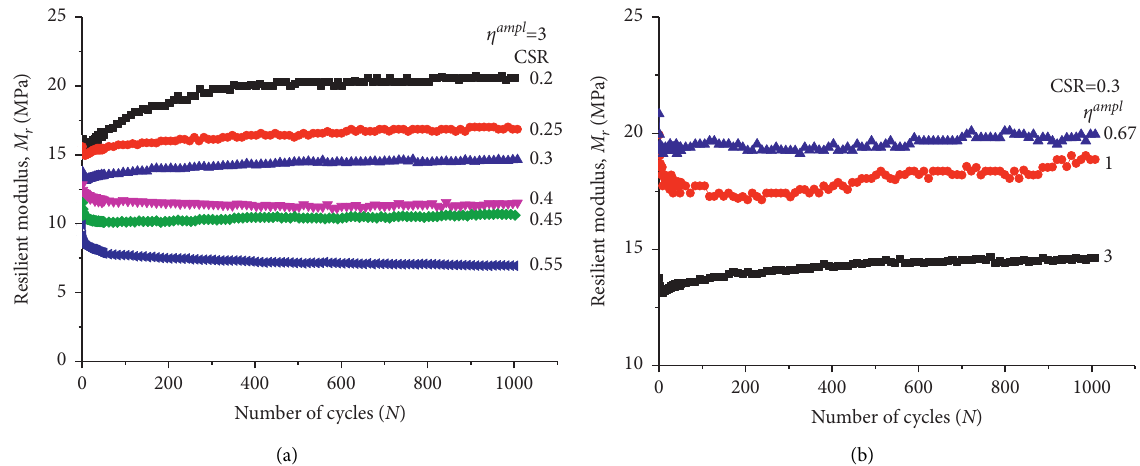
Figure 5: Effect of CSR and stress path on resilient modulus: (a) η ampl � 3 and (b) CSR �